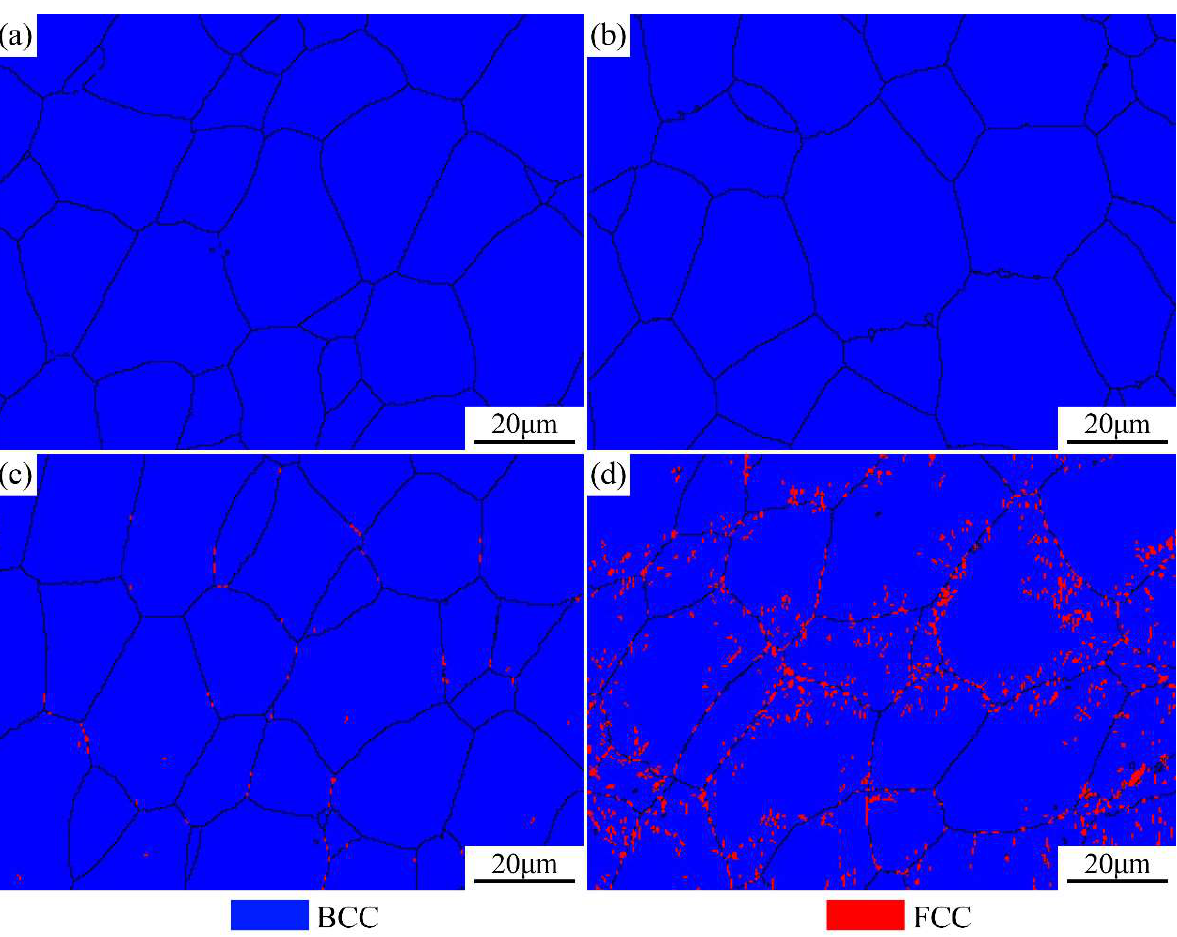
Figure 3. EBSD-phase analysis results of the AlCoCrFeNi components before and after high-temperature treatment: ( a ) as-fabricated; heat-treated at ( b ) 600 ◦ C, ( c ) 800 ◦ C, and ( d ) 1000 ◦ C. The content of the FCC phase in the component heat-treated at 1000 ◦ C increased significantly to about 12.7%, as shown in Figure 3d. In addition to being distributed at the grain boundaries, the FCC phase also precipitated inside the